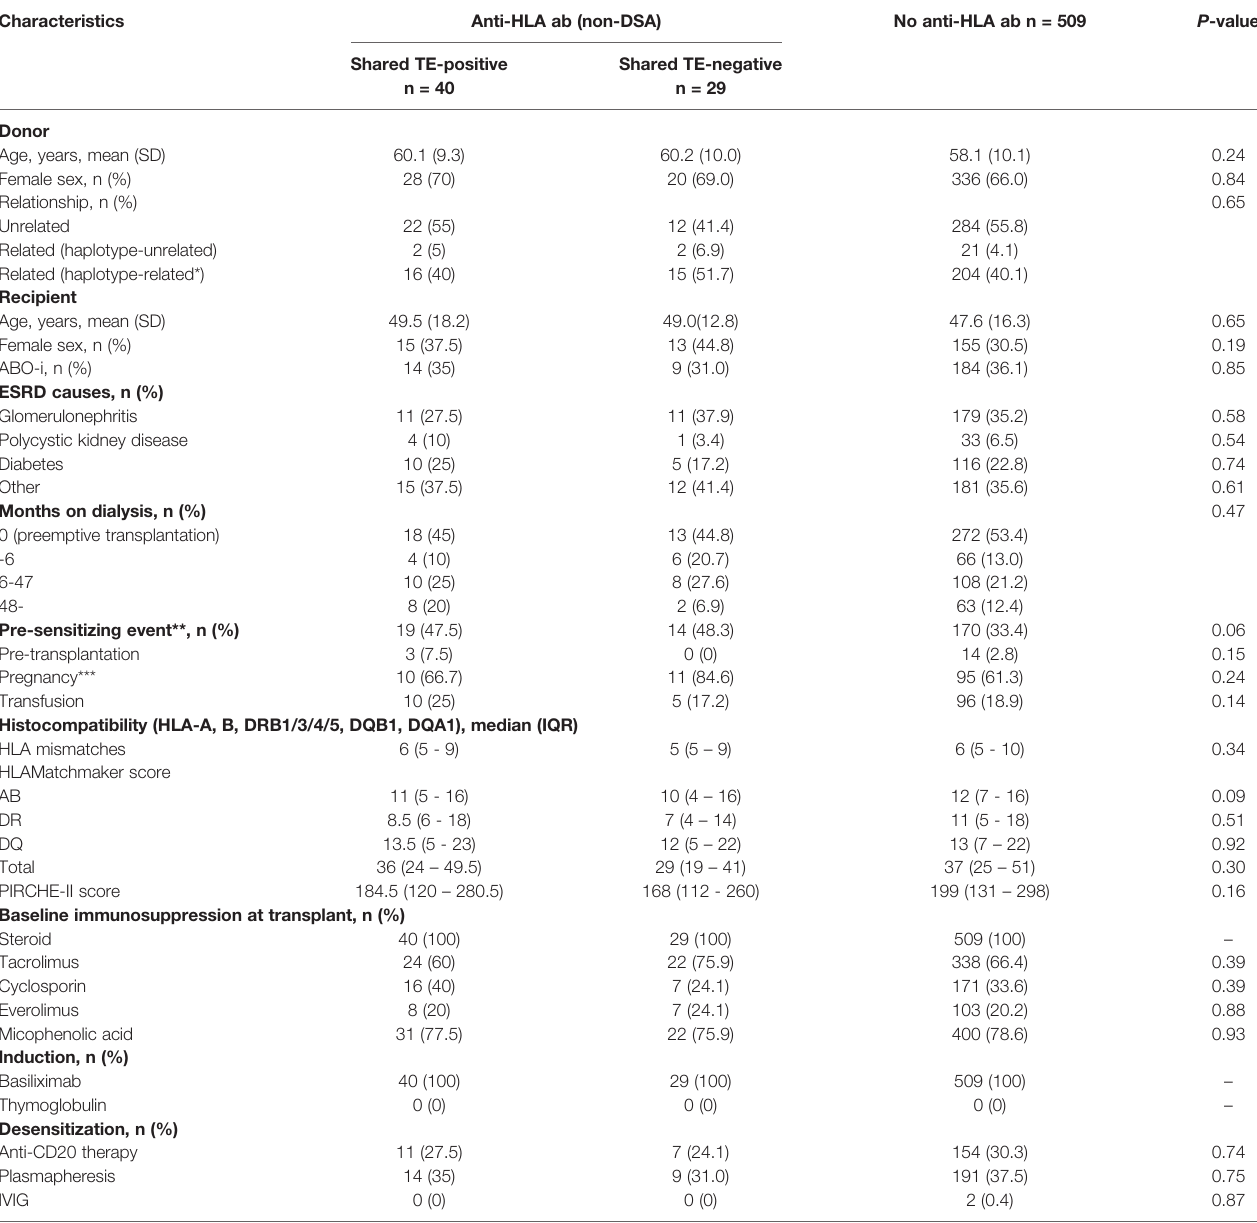
TABLE 1 | Patient